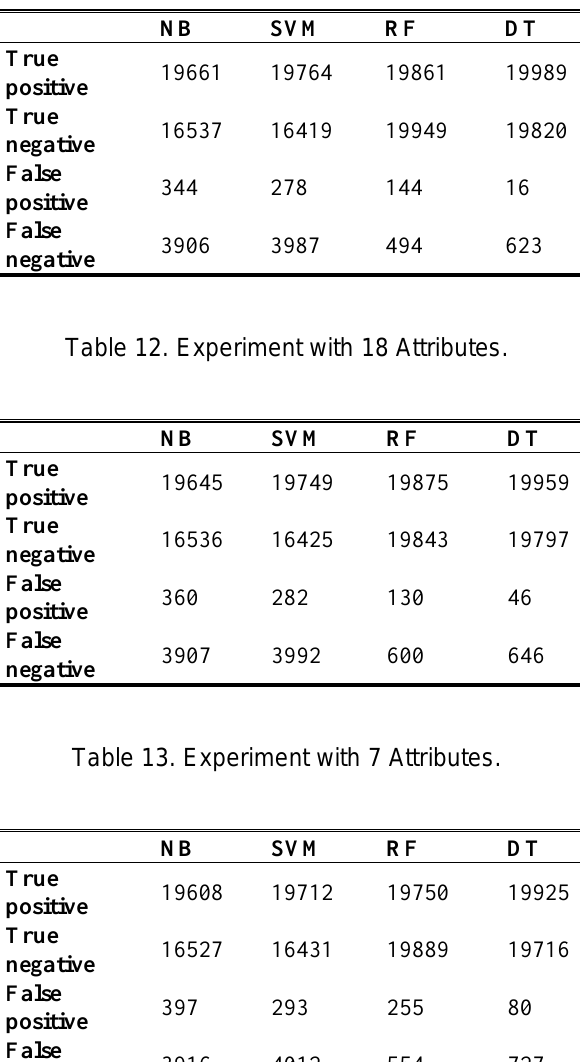
Table 11. Experiment with 24 Attributes.